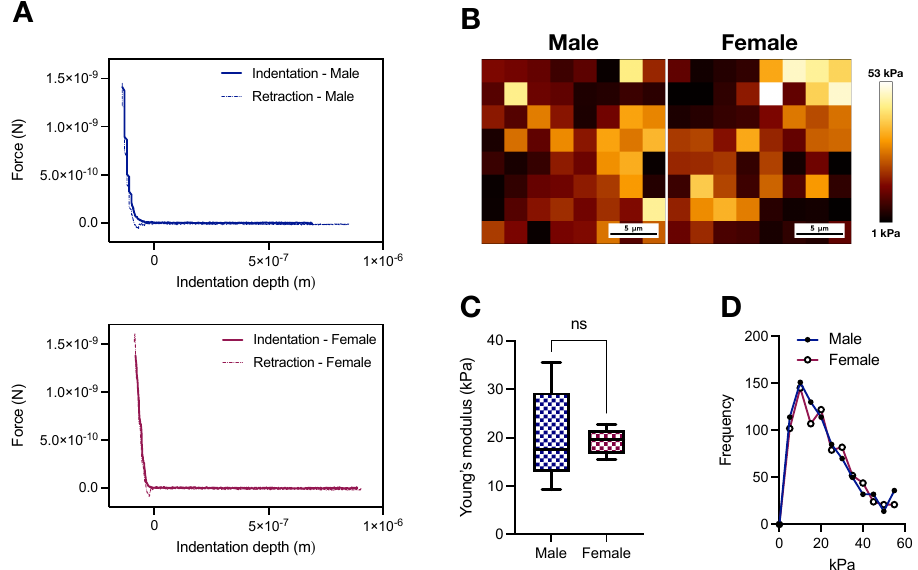
Figure 1. Male and female Wistar rats display similar atomic force microscopy-based media-layer stiffness at 16 weeks of age. ( A ) Representative force indentation curves and ( B ) AFM-based stiffness map for male and female samples. ( C ) Averaged Young’s modulus derived from the Hertz Model and ( D ) frequency of the measured stiffness. In ( C ), data are depicted as min to max, n = 5. ns. p > 0.05 using two-tailed Student’s t